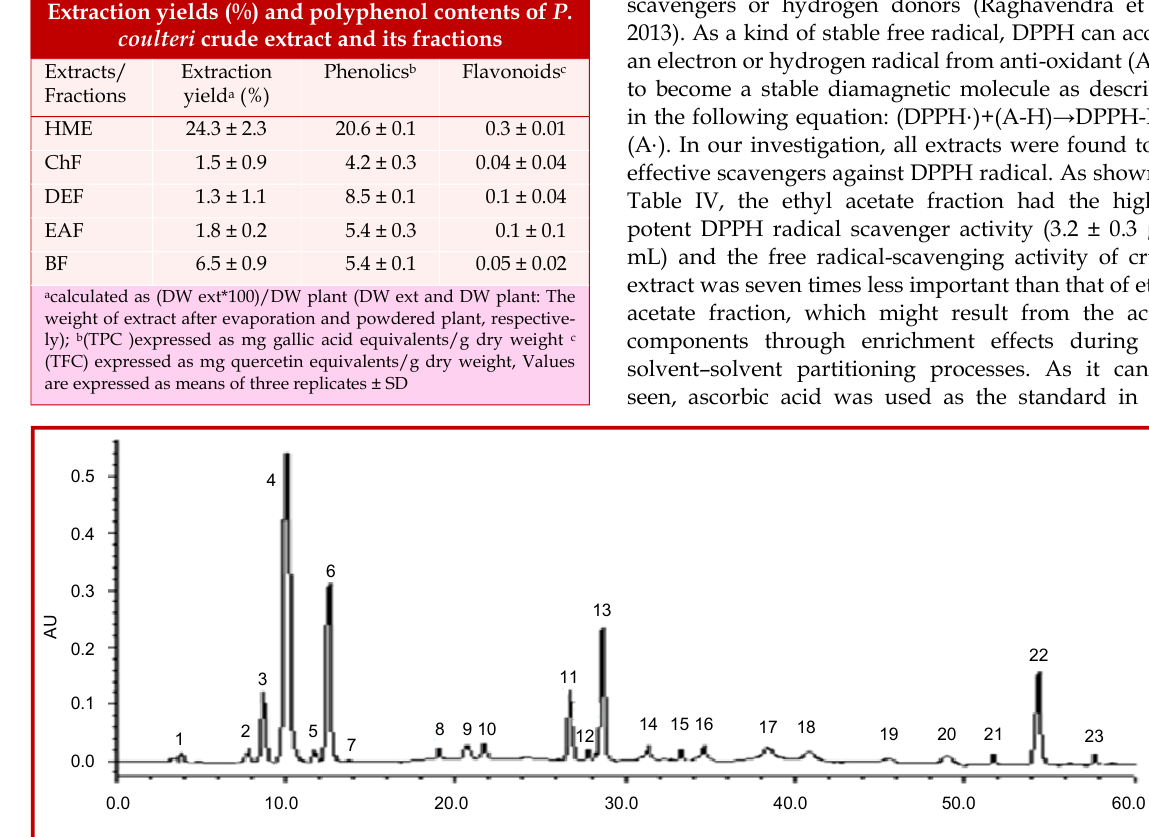
Extraction yields (%) and polyphenol contents of P.